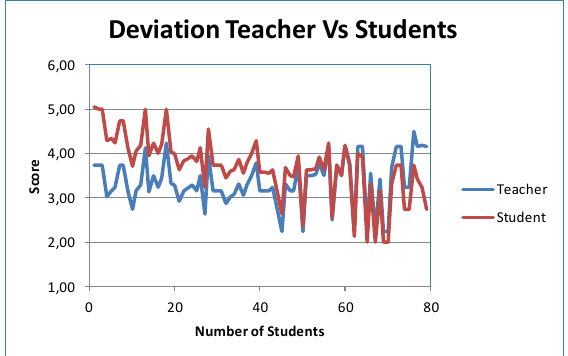
Figure 7 . Deviation between of teacher and total of students in “guess the